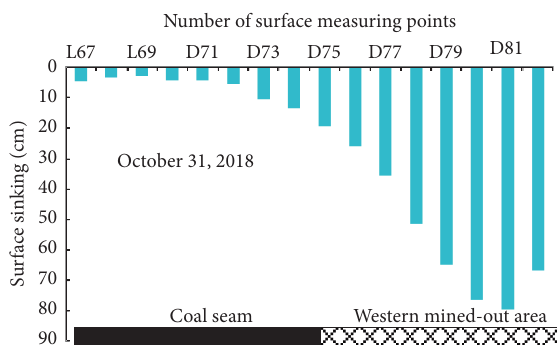
Figure 5: Surface subsidence